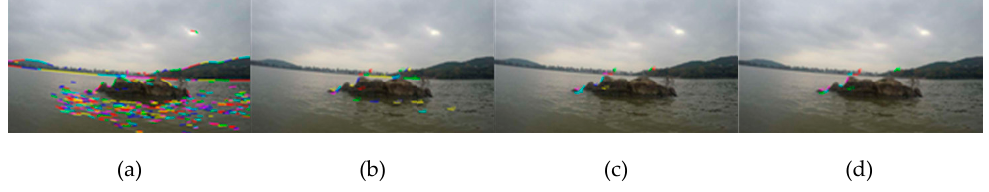
Figure 18. The failure case of this method: ( a )–( d ) are respectively line segment extraction, line segment matching, line segment pool rough selection and line segment pool fine selection.